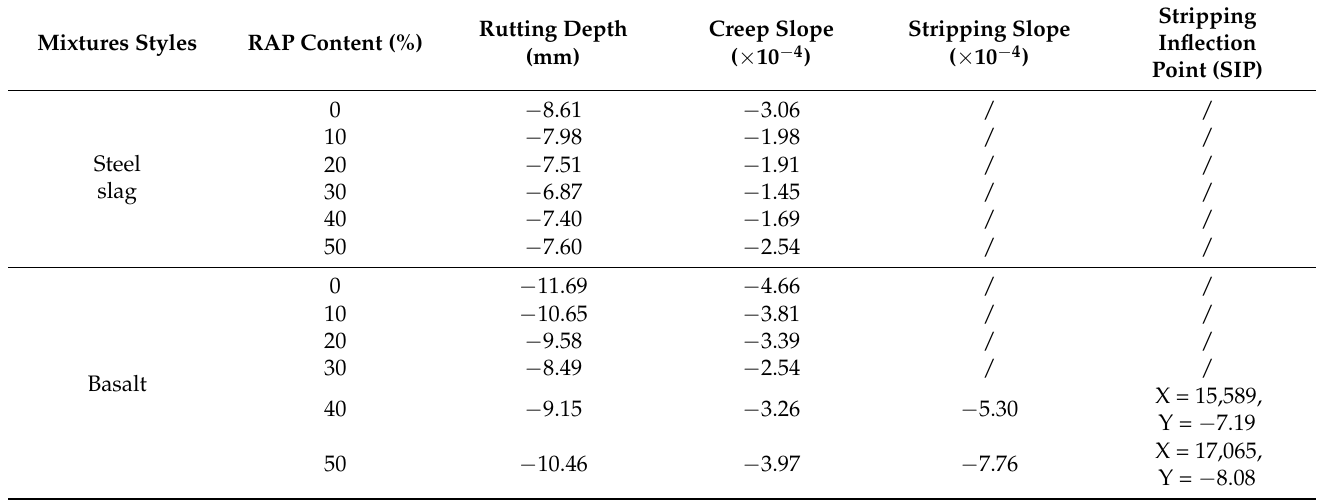
Table 5. The characterization parameters of RAM in HWT test.